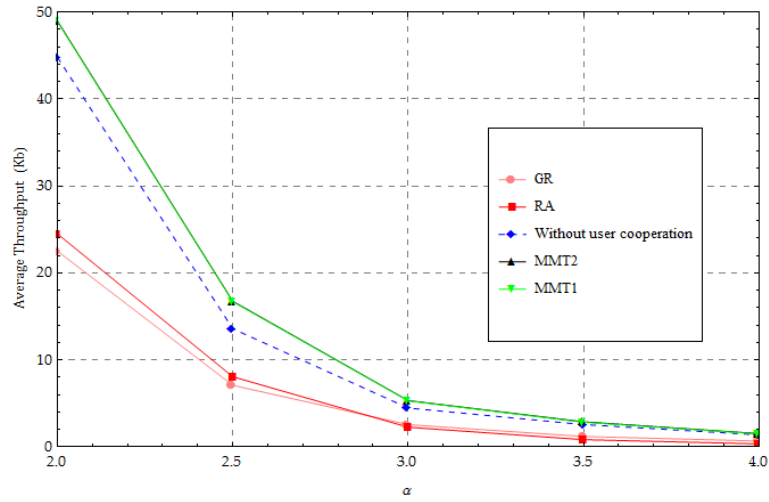
Figure 7. Change in the path-loss exponent.